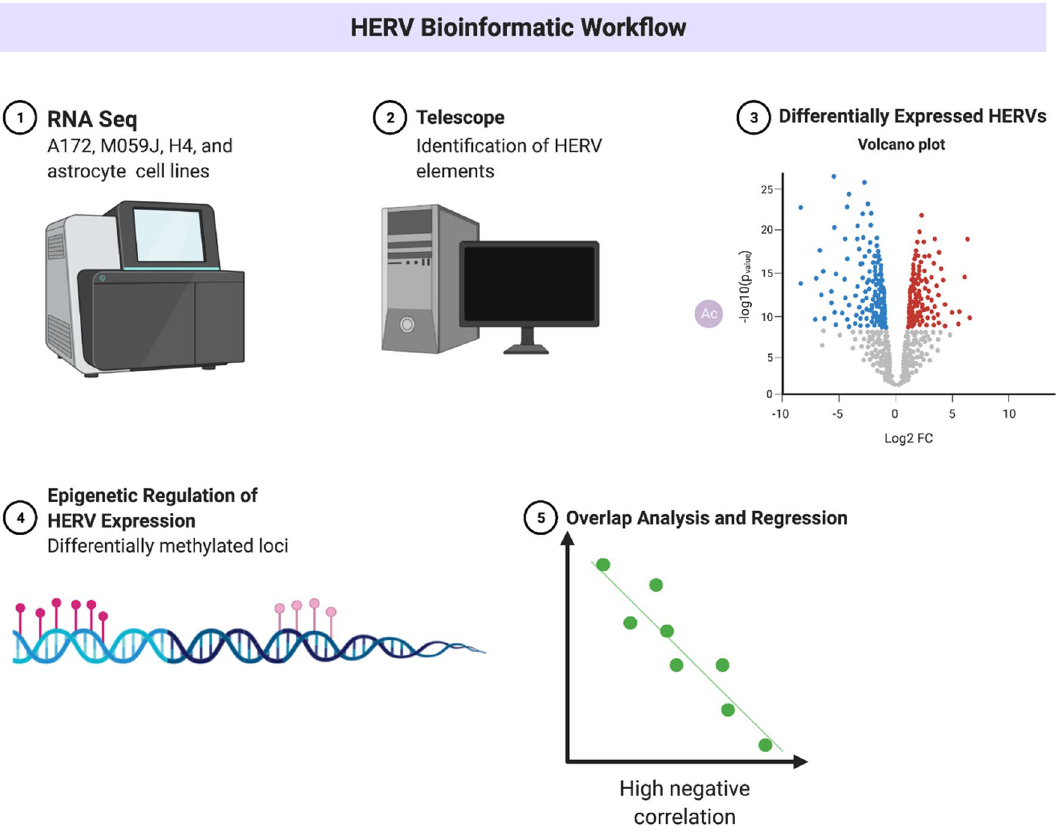
Figure 6. Summary of bioinformatics workflow. Created with